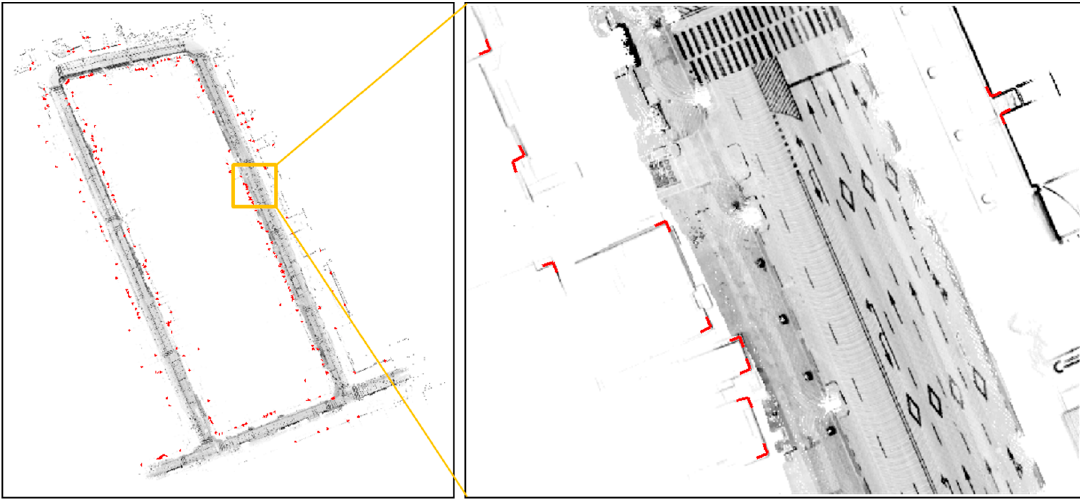
Figure 13. Generated corner map information (on synthetic map).